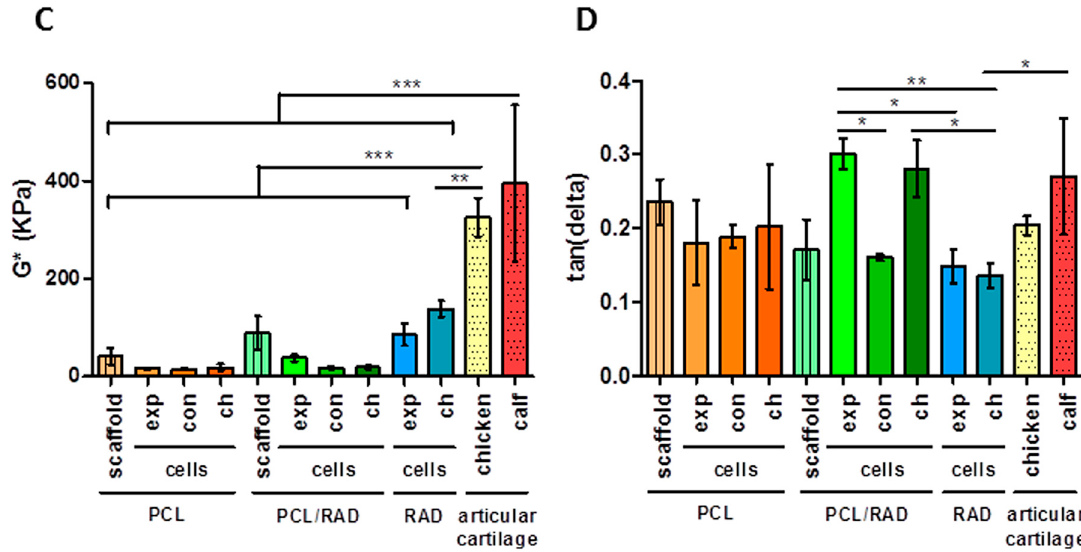
Figure 6. Mechanical characterization of PCL-based scaffolds and Articular Chondrocytes (AC) 3D constructs after 4 weeks of culture. ( A ) Storage modulus (G’) measures the sample’s elastic behavior; ( B ) Loss modulus (G”) measures the viscous response of the material; ( C ) Complex modulus (G*) is the sum of storage and loss modulus; ( D ) Tan (delta) is the ratio of the loss to the storage. PCL scaffold and PCL/RAD composite scaffold refers to the acellular scaffold. 3D AC constructs cultured in expansion (exp), control (con), and chondrogenic (ch) media. Small pieces of articular cartilage of chicken and calf were measured in the same conditions (Statistical differences are indicated as: * for p < 0.05, ** for p < 0.01, and *** for p < 0.001, One-way ANOVA, N = 2 n = 3).